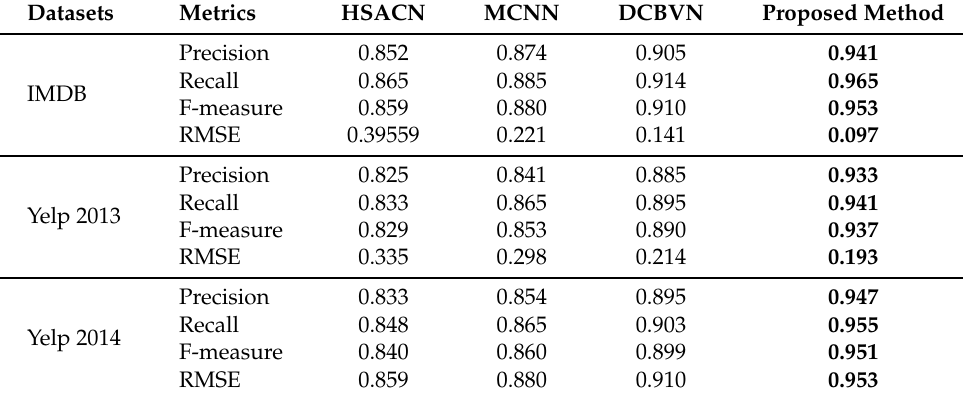
Table 2. Comparison of proposed spider Taylor-ChOA-based RMDL with existing methods based on sentiment classification, in terms of precision, recall, F-measure and RMSE. The best results are displayed in